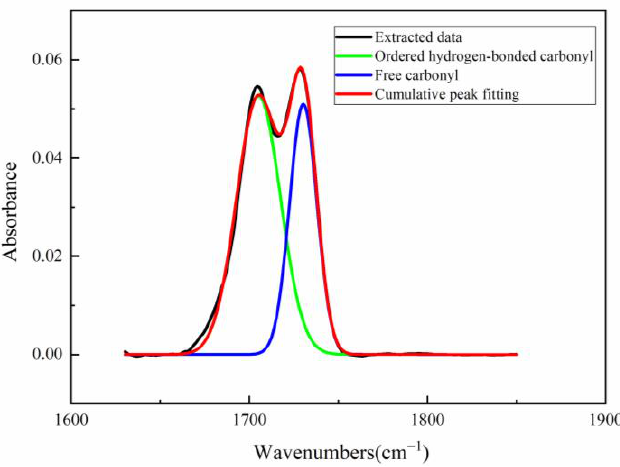
Figure 5. FTIR Spectra of carbonyl region for PUME at 23 °C ± 2 °C.